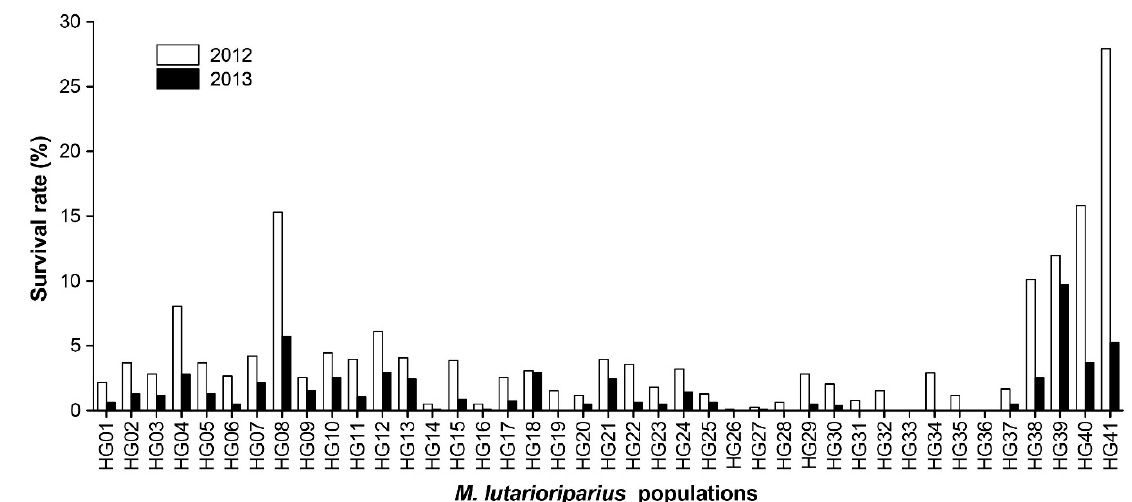
Figure 1. The variation in the survival rate of Miscanthus lutarioriparius populations in two growing seasons. The black bars represent the survival rates of populations in the 2012 growing season and the grey bars represent the survival rates of populations in the 2013 growing season, all based on the total number of plants grown in 2011.